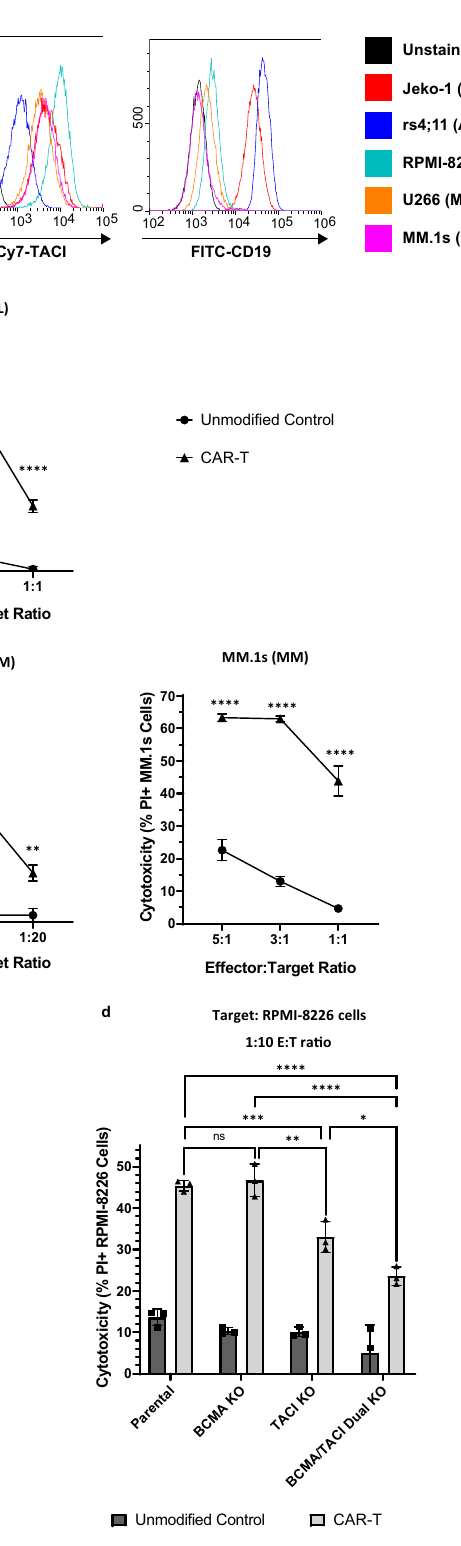
express the fi re fl y luciferase gene (Jeko-1-luc). Male or female NSG mice were injected intravenously (i.v.) with Jeko-1-luc cells (1.5e6) and on Day 9 post-tumor inoculation, mice were injected i.v. with BAFF CAR-T (10e6) or unmodi fi ed Control-T cells (10e6) (Supplementary Fig. 5a). Bioluminescent imaging was conducted weekly until Day 36 (Fig. 6a and Supplementary